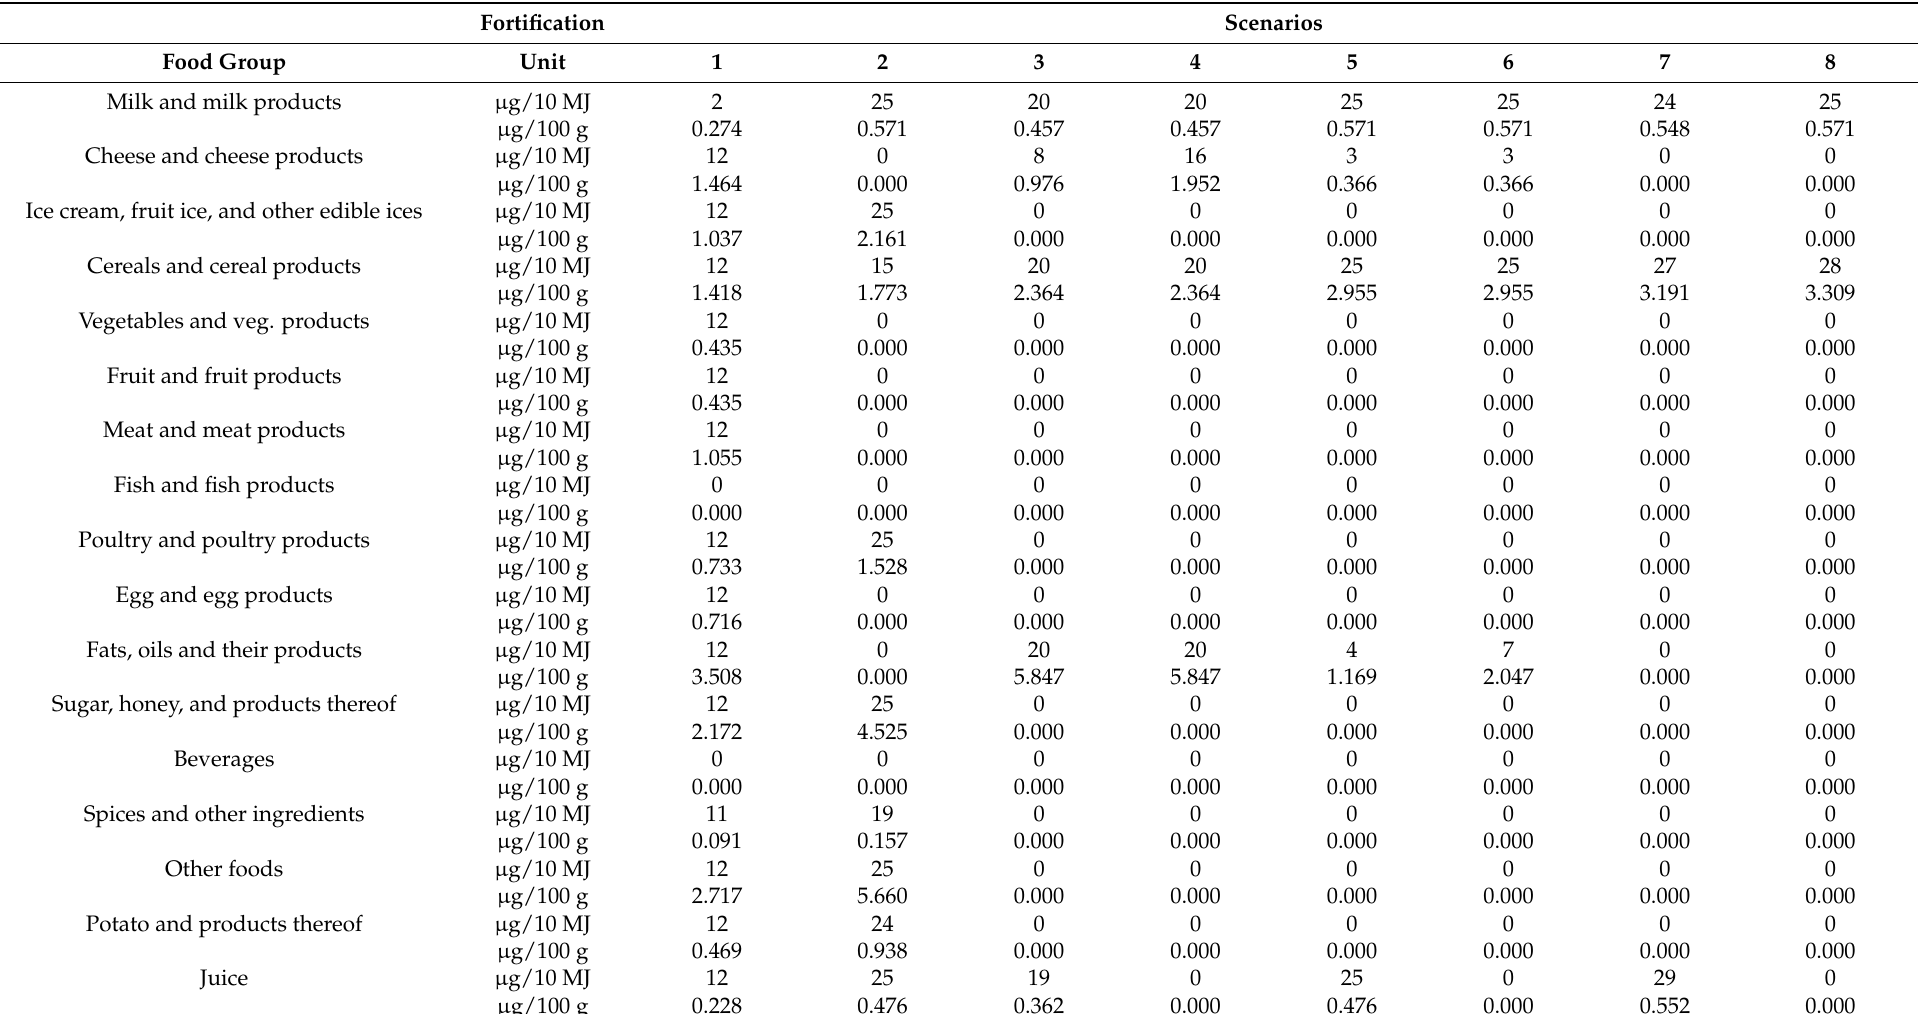
Table 2. Optimized scenarios, level of fortification of food group per 10 MJ and per 100